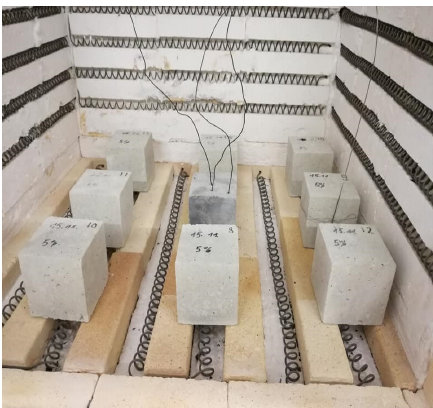
Figure 4. View of cubic samples before temperature loading, thermocouple fixing.